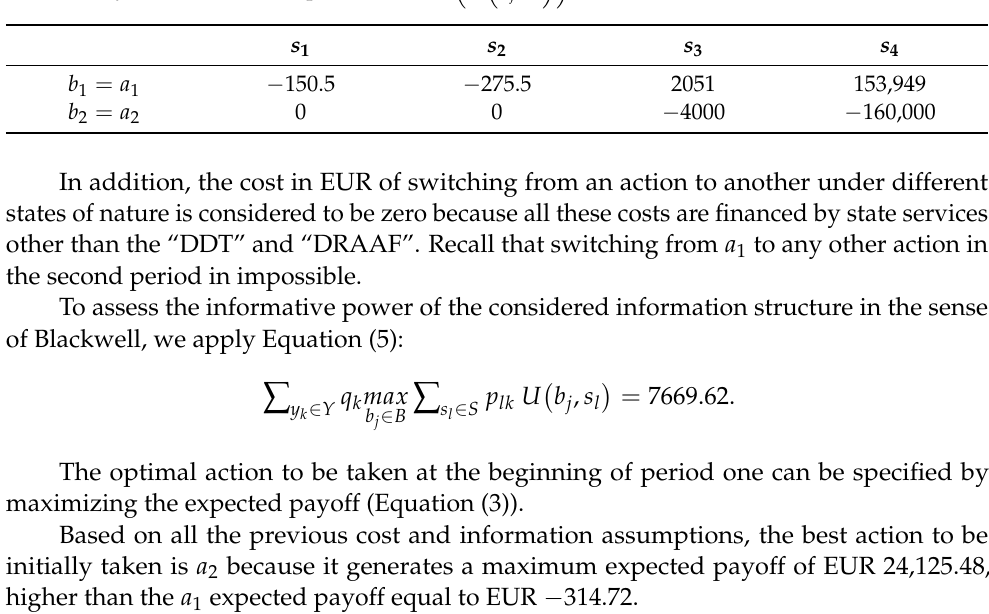
Table 5. Payoffs of the second period actions